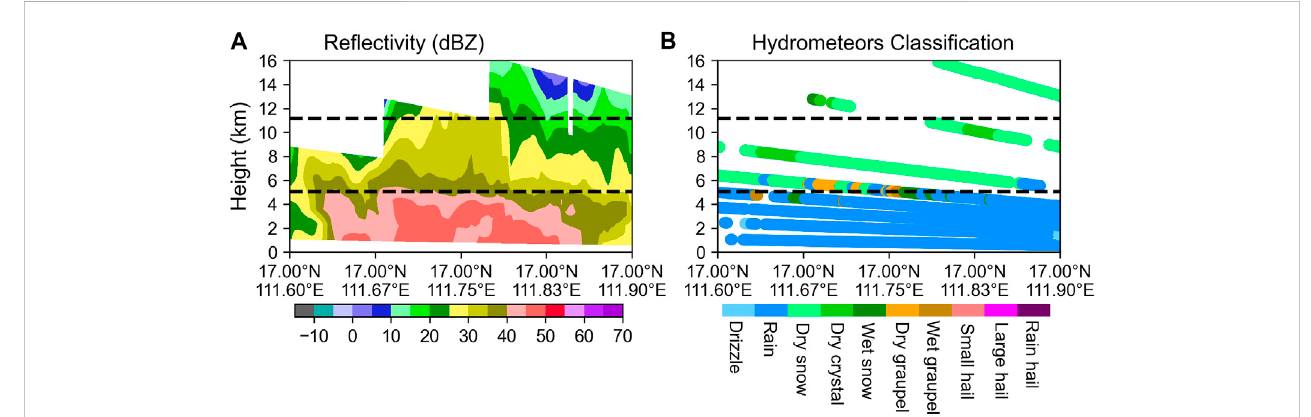
FIGURE 7 Distributionof (A) radarre fl ectivity(units:dBZ)and (B) hydrometeorsat4.3 ° elevationintheconvectivecloudsat21:43on16Octoberalongthesectionin Figure 2D. The black dashed line represents 0 ° C and − 38 ° C isotherms, respectively.